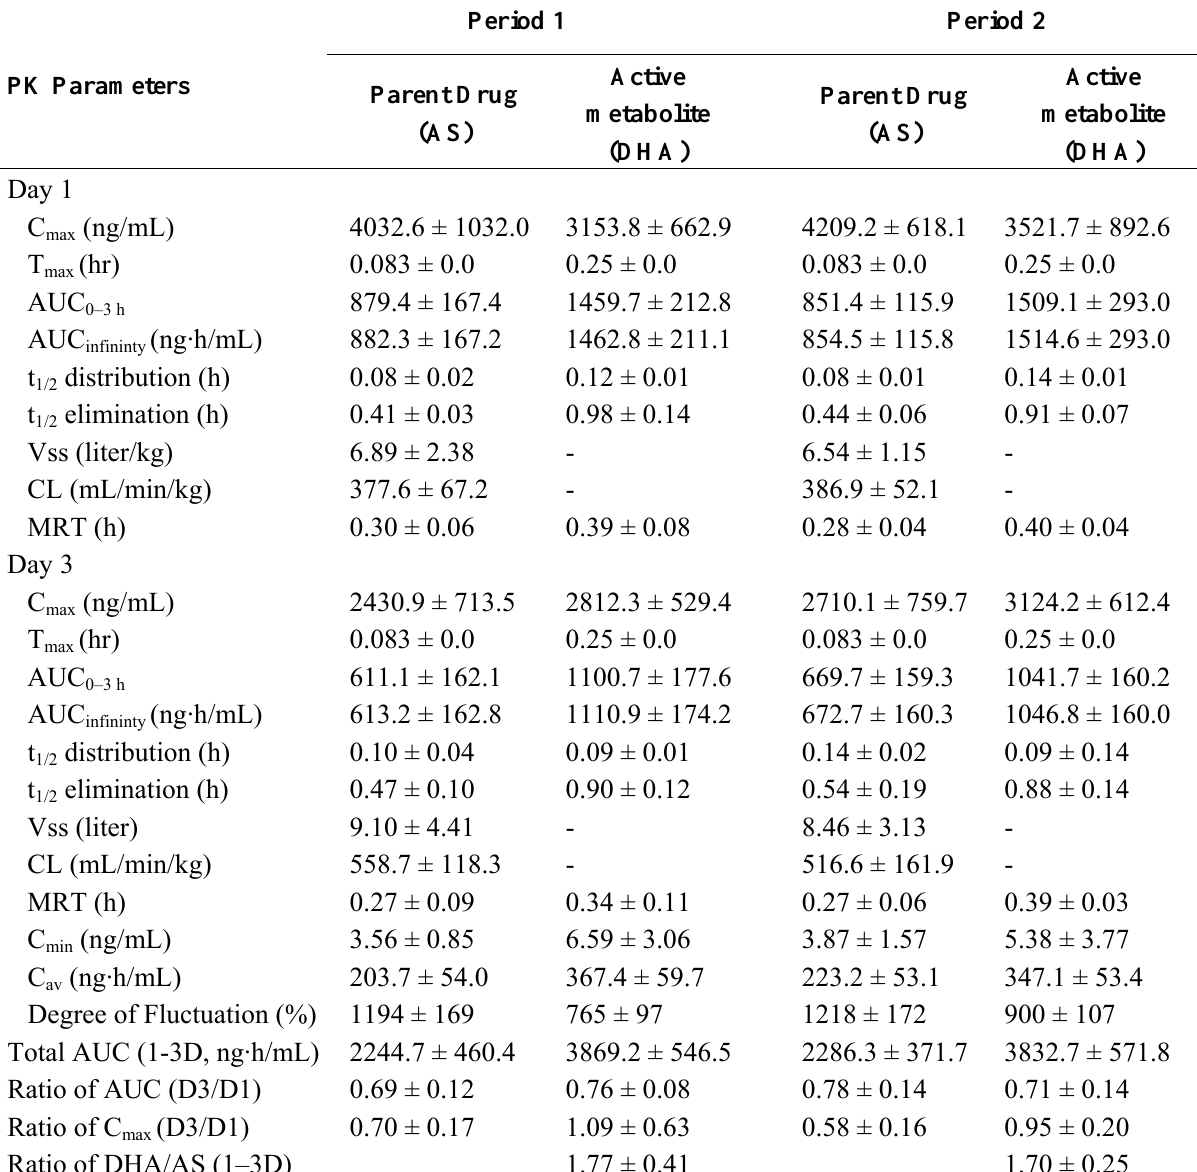
Table 2. Pharmacokinetic parameters of artesunate (AS/0.3M PBS Buffer, a WRAIR formulation) and dihydroartemisinin (DHA), an active metabolite of AS, at dose of 20 mg/kg following single and multiple intravenous injection daily for three days in male rats in two- period (n =